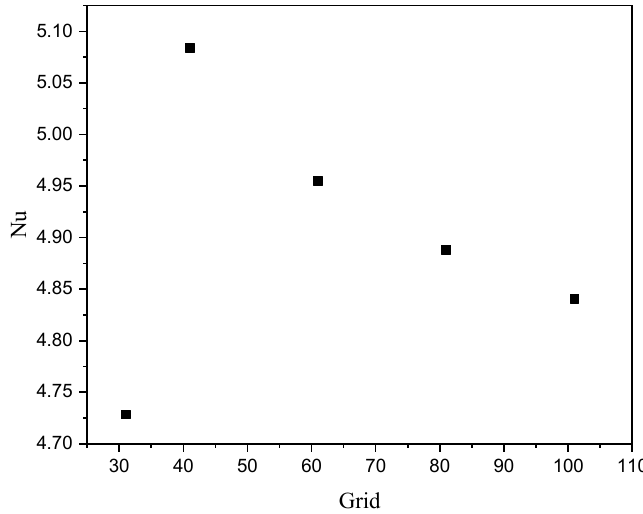
= L = 0.5, γ = 45, 2 1 1